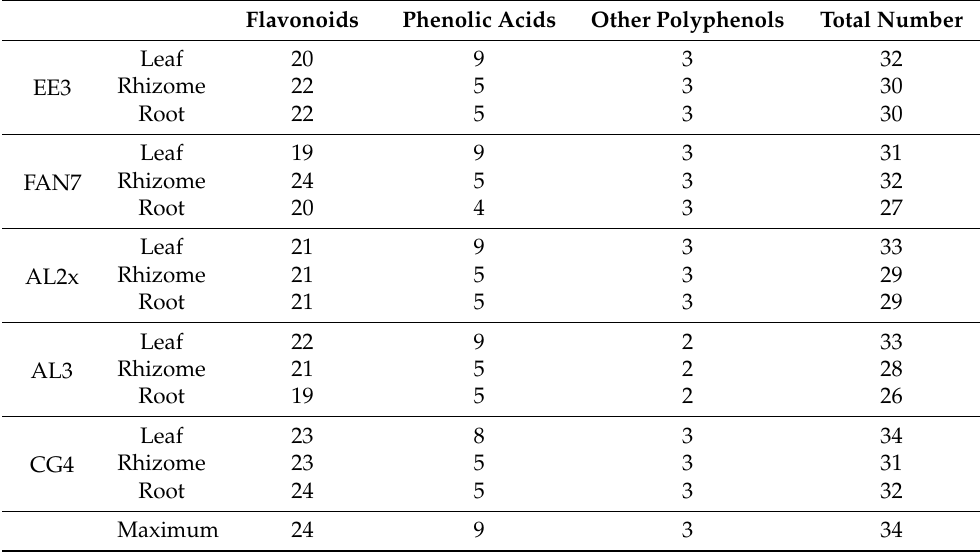
Table 4. Phenolic families detected in P. oceanica tissues and the maximum number observed in the